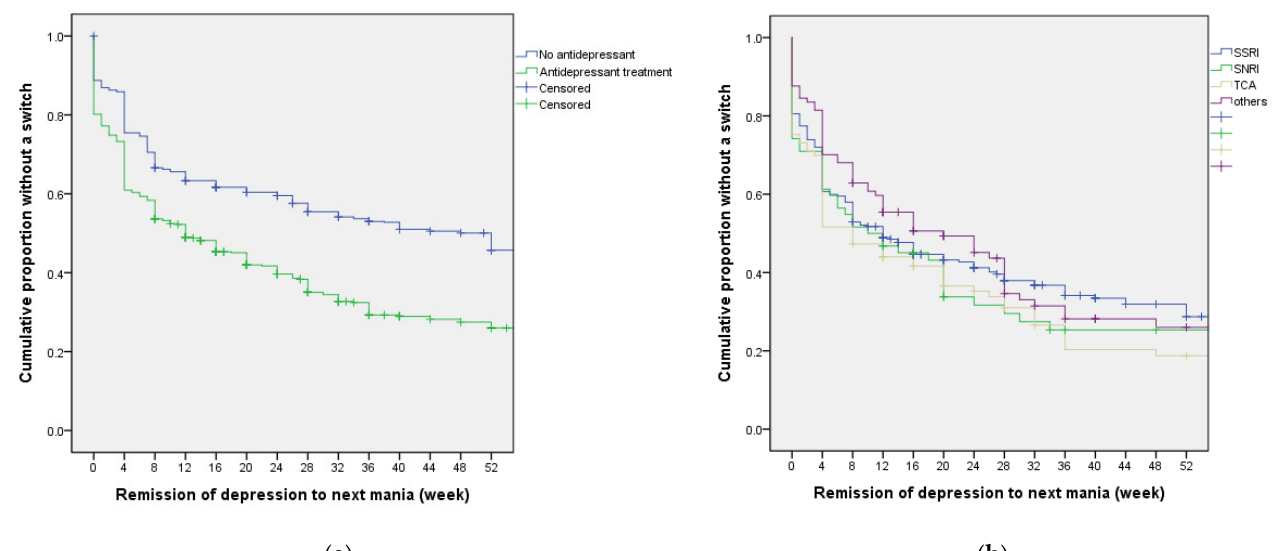
Figure 2. Survival functions of manic switch or recurrence after remission of the first depressive episode among bipolar I patients. ( a ) Among patients with bipolar I disorder (N = 1004), 511 received antidepressant treatments, while 493 did not for their first depressive episodes. Median survival time to manic switch or recurrence following remission of the first depressive episode was 12.0 (95% CI 8.5–15.5) weeks and 52.0 (95% CI 39.9–64.1) weeks for those with and without antidepressant treatment, respectively (chi-square = 68.2, p < 0.001). ( b ) Among patients who had antidepressant treatments for the first depressive episode (N = 511), the median survival time to the manic episode for those treated with SSRI (N = 257), SNRI (N = 62), TCA (N = 93), and other antidepressants (N = 99) were 12.0 (95% CI 7.9–16.1) weeks, 10.0 (95% CI 0.0–21.2) weeks, 8.0 (95% CI 4.5–11.5) weeks, and 20.0 (95% CI 7.9–32.1) weeks, respectively. Patients treated with TCA had a lower mean survival time than patients treated with other antidepressants (Generalized Wilcoxon test chi-square = 4.6, p = 0.032). SSRI: Selective serotonin reuptake inhibitors; SNRI: Serotonin and norepinephrine reuptake inhibitors; TCA: Tricyclic